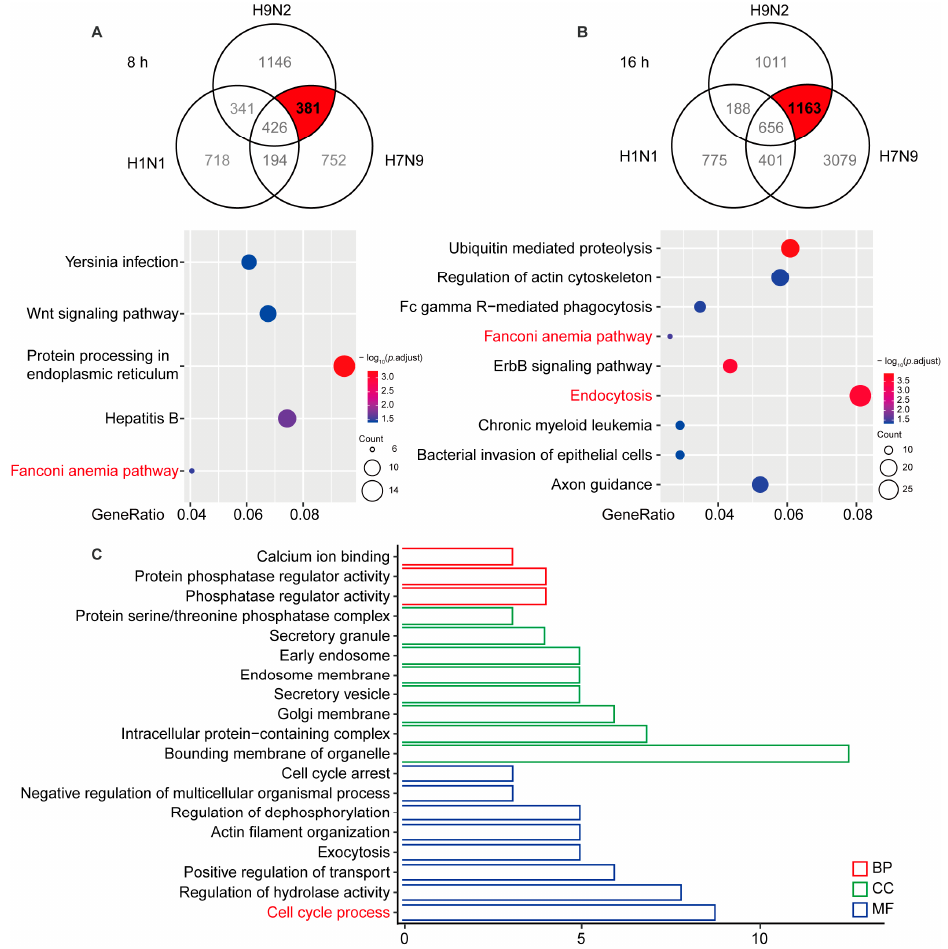
Figure 2. Significantly up-regulated avian virus-specific circRNAs by functional analysis of cis- targeting genes. ( A ) A549 cells infected with H1N1/H7N9/H9N2 subtype IAV for 8 h. The Venn diagram reflects significantly up-regulated circRNAs (top), and the host gene-enriched pathways of circRNAs specifically up-regulated by avian origin IAV were analyzed by KEGG (bottom). ( B ) A549 cells infected with H1N1/H7N9/H9N2 subtype IAV for 16 h. The Venn diagram reflects significantly up-regulated circRNAs (top) and KEGG pathway analysis (bottom). Gene ratio is the ratio of the number of DE genes recorded in a pathway item to the number of all genes recorded in that pathway item. The greater the proportion of genes, the higher the intensity. p -values were adjusted ranging from 1.5 to 3.5 (blue to red). Lower p -adjustment indicates higher intensity. ( C ) GO analysis of specifically up-regulated host genes of circRNAs at 8 and 16 h. GO enrichment of these genes indicates that biological processes and molecular functions are most enriched, depending on the p